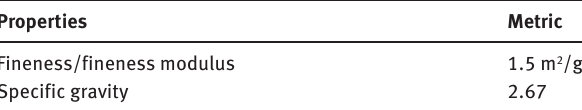
Table 2: Properties of marble dust.